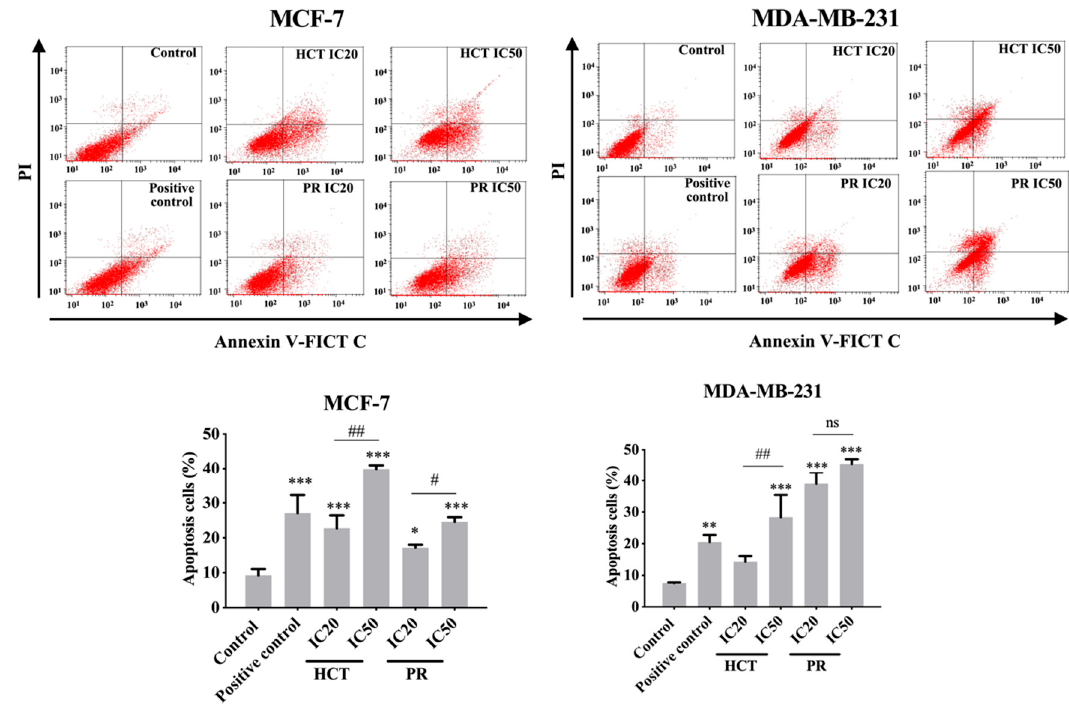
Figure 8. Effect of H. cordata and P. ribesioides extracts on apoptosis induction in breast cancer cells. Flow cytometric analysis of apoptosis induction on MCF-7 and MDA-MB-231 cells were treated with various concentrations of HCT and PR ethanolic extracts for 24 h. The annexin V-FITC/PI staining apoptotic cells were analyzed using flow cytometry. Camptothecin (CTP; 5 nM) was used as a positive control. Bar graphs showed the summarized data of three independent experiments from MCF-7 (left) and MDA-MB-231 cells (right), performed in duplicate compared with the untreated control. Each value is presented as mean ± SD from three independent experiments. Data are the means ± SD. * p < 0.05, ** p < 0.01, and *** p < 0.001 vs. control. # p < 0.01 and ## p < 0.001 vs. IC20 of each extract. ns, not